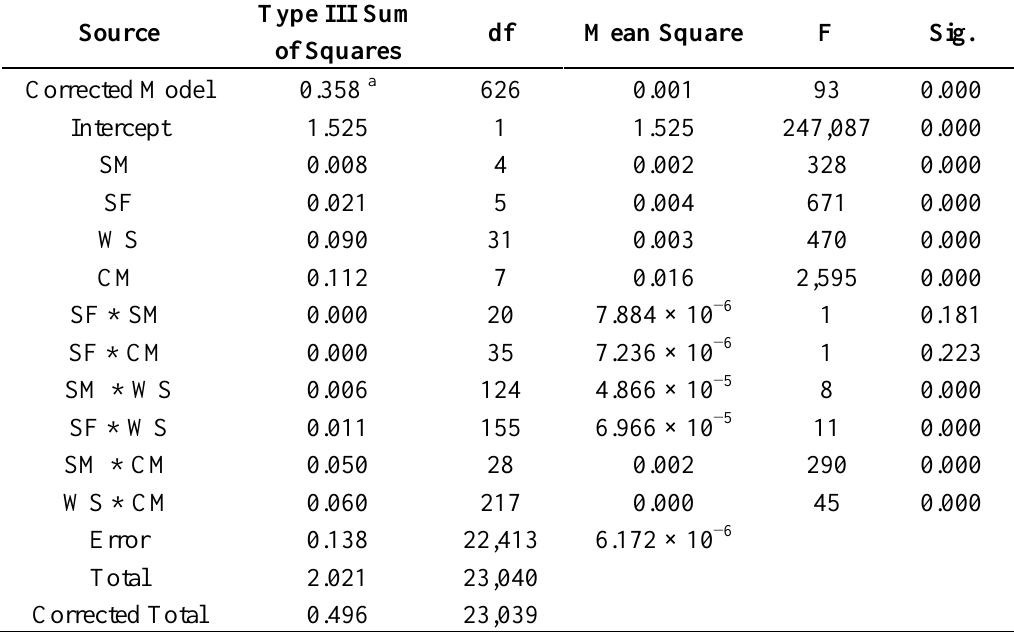
Table 5. ANOVA output for the CL as the dependent variable ( Tests of Between-Subjects Effects. Dependent Variable: CL